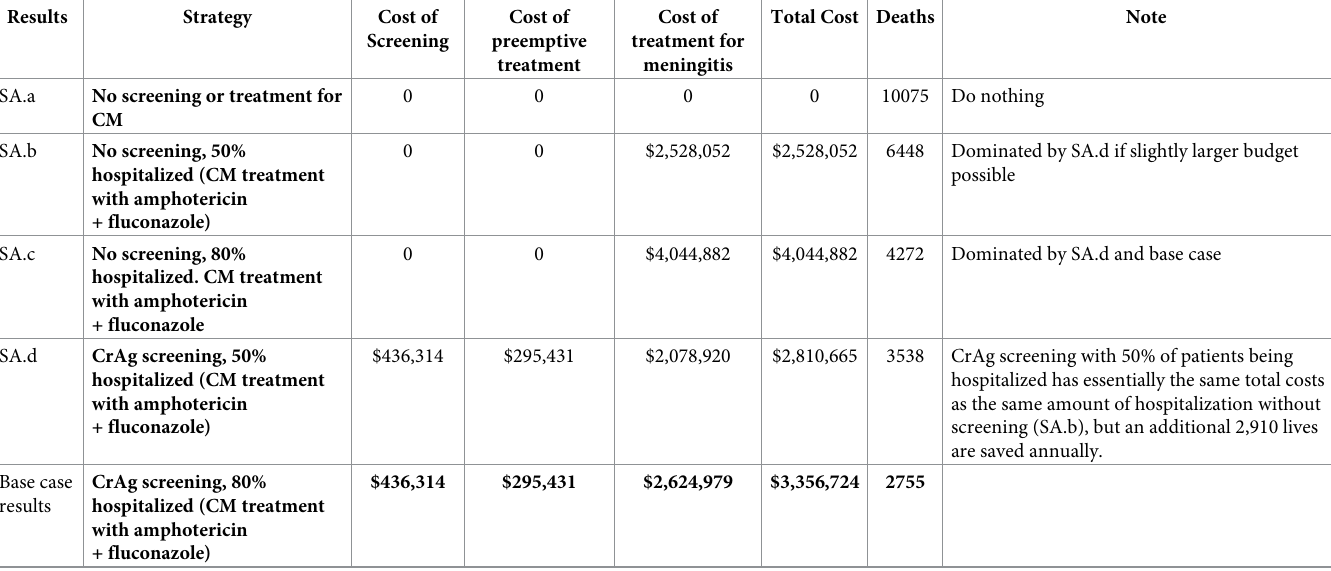
Table 5. Sensitivity of results to level of CrAg screening and proportion of patients with meningitis